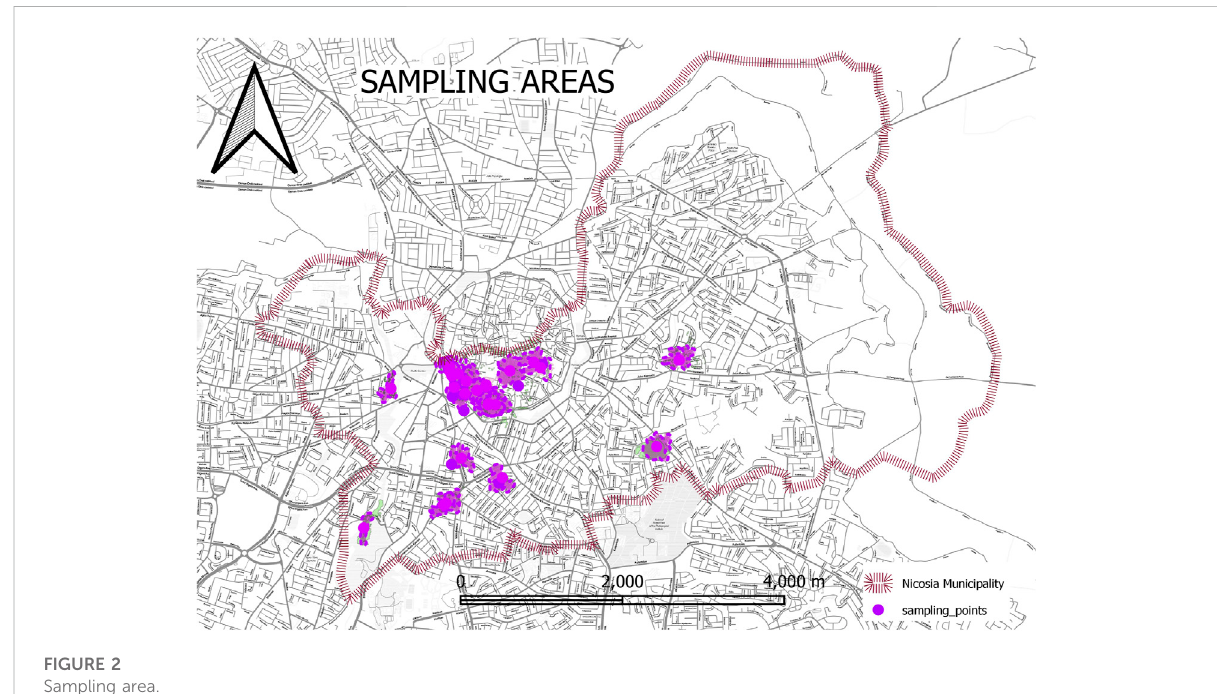
FIGURE 2 Sampling